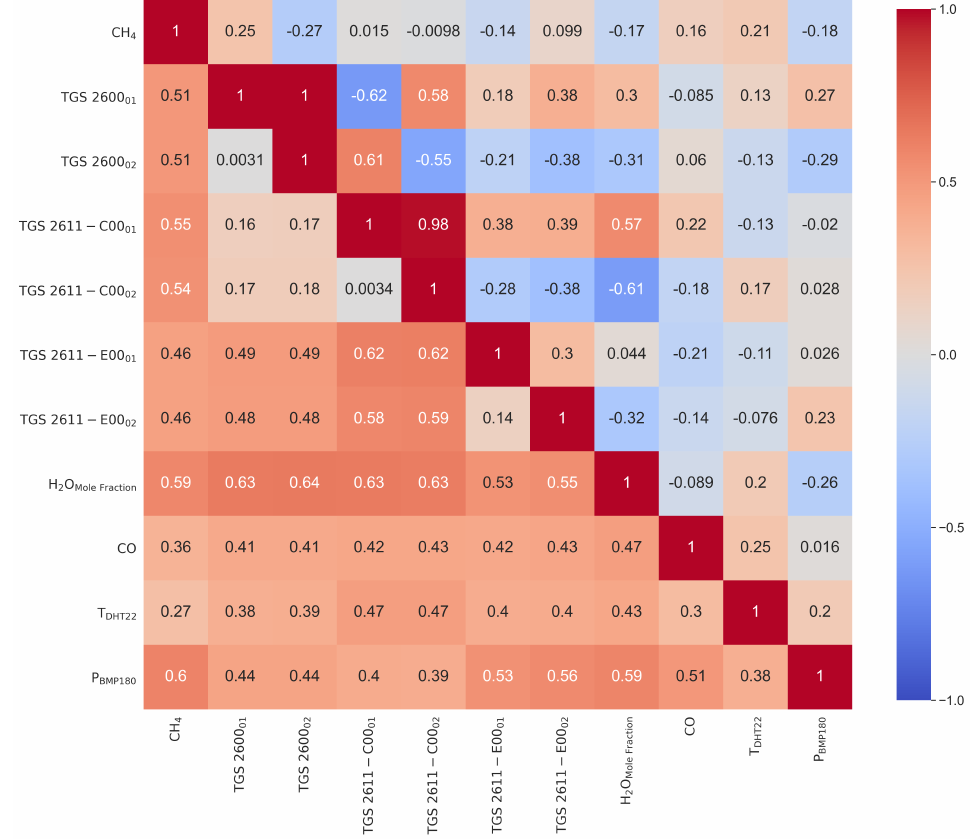
Figure 6. Partial correlation (r) matrix (upper triangular) and standard deviation of correlation for bins of 3 days previously smoothed at 20 min scale on 3 consecutive hours (lower